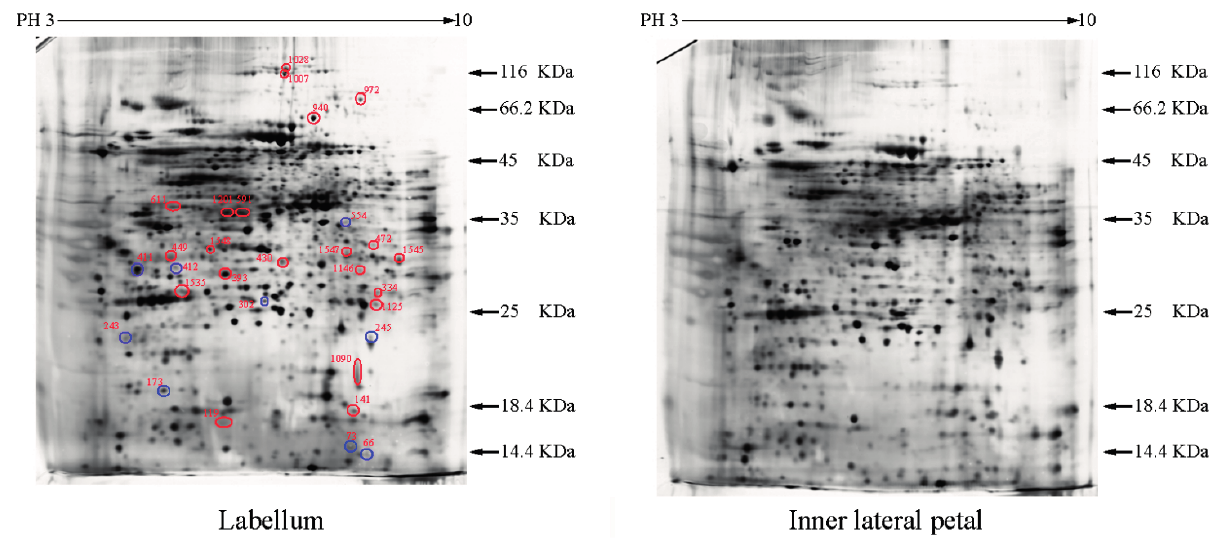
Figure 1. Protein expression profiles for labellum and inner lateral petal. Proteins were separated in the first dimension by isoelectric focusing (pH 3–10), in the second dimension by SDS-PAGE in 12.5% ( w / v ) polyacrylamide gels, and then silver stained. Proteins that were up regulated (red circles) or down regulated (blue circles) in